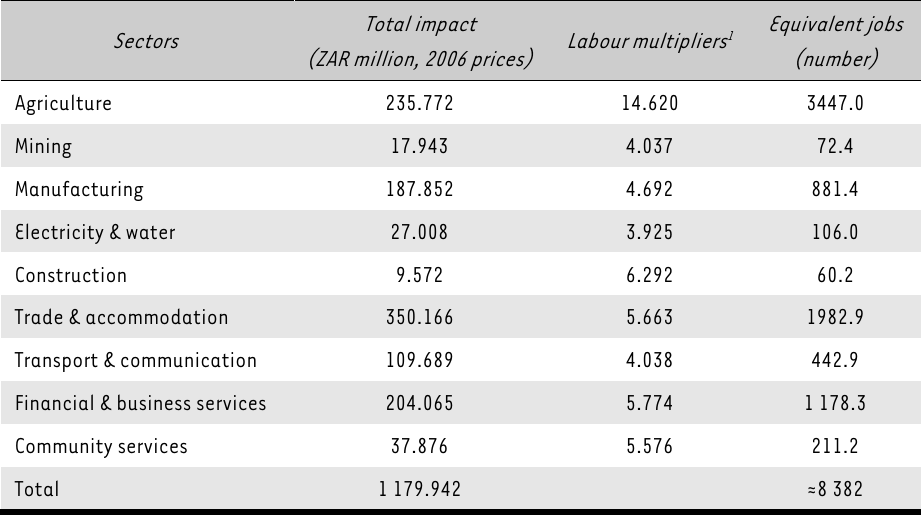
Impact at the level of